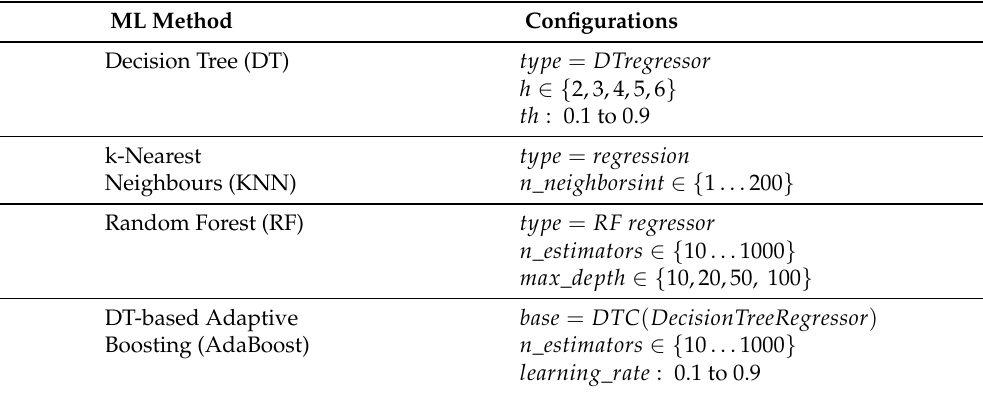
Table 11. Used configurations in the ML tuning step.